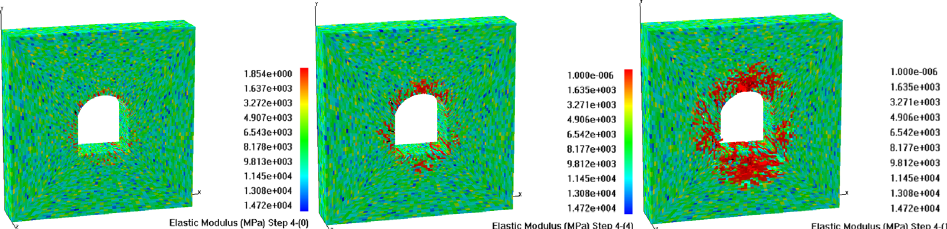
Figure 6. Distribution of the elastic modulus.